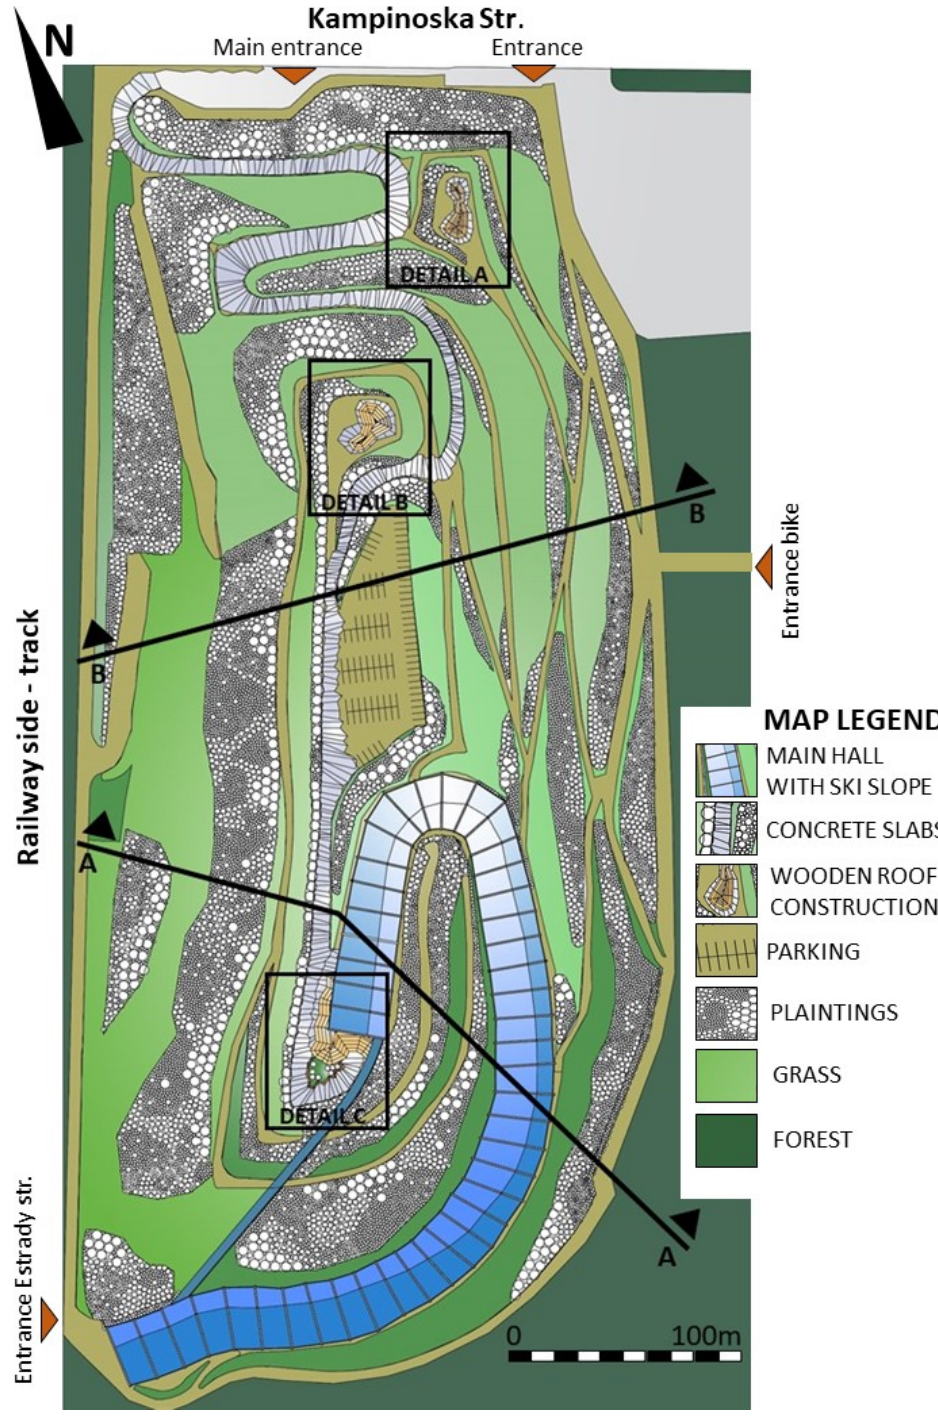
Figure 3. The concept of the landfill development plan with details presented in Figure 4 and cross-sections showing the slope geometry with reinforcement elements in Figure 5.